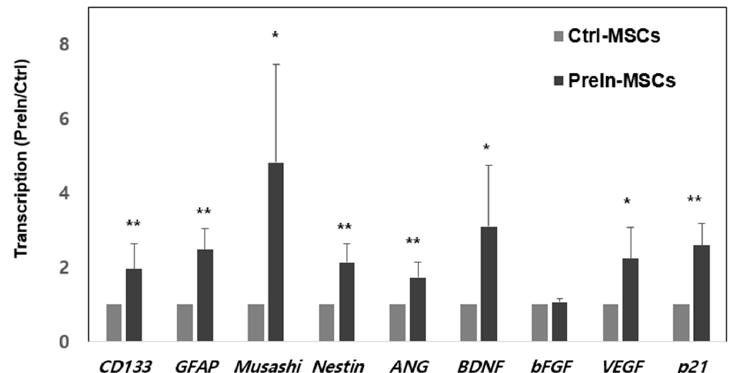
Figure 1. The expression of specific markers was identified by real-time PCR. Transcripts of neuro- progenitor markers ( CD133, GFAP, Musashi, and Nestin ), trophic factors ( ANG, BDNF, and VEGF ), and p21 were significantly increased in pre-induced-MSCs ( t -test, * p < 0.05, ** p < 0.005, mean ± SD n = 6). Control-MSCs: control-MSCs. PreIn-MSCs: preinduced-MSCs which are incubated with pre-induction media for 24 h.